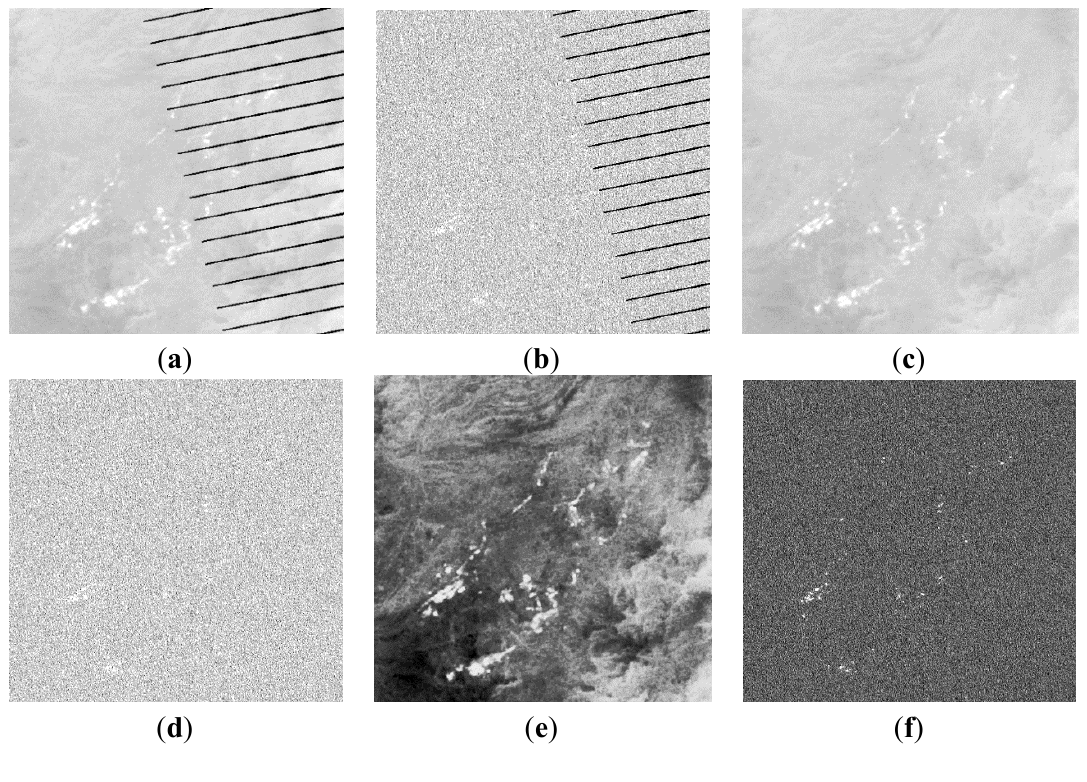
Figure 3. ( a ) SLC-OFF effects on the thermal band 6 data. ( b ) Gap-filling with the thermal band 6 data. ( c ) Image enhancing with Gaussian algorithm. ( d ) SLC-OFF effects on the SWIR band 6 data. ( e ) Gap-filling with the SWIR band 6 data. ( f ) Image enhancing with Gaussian